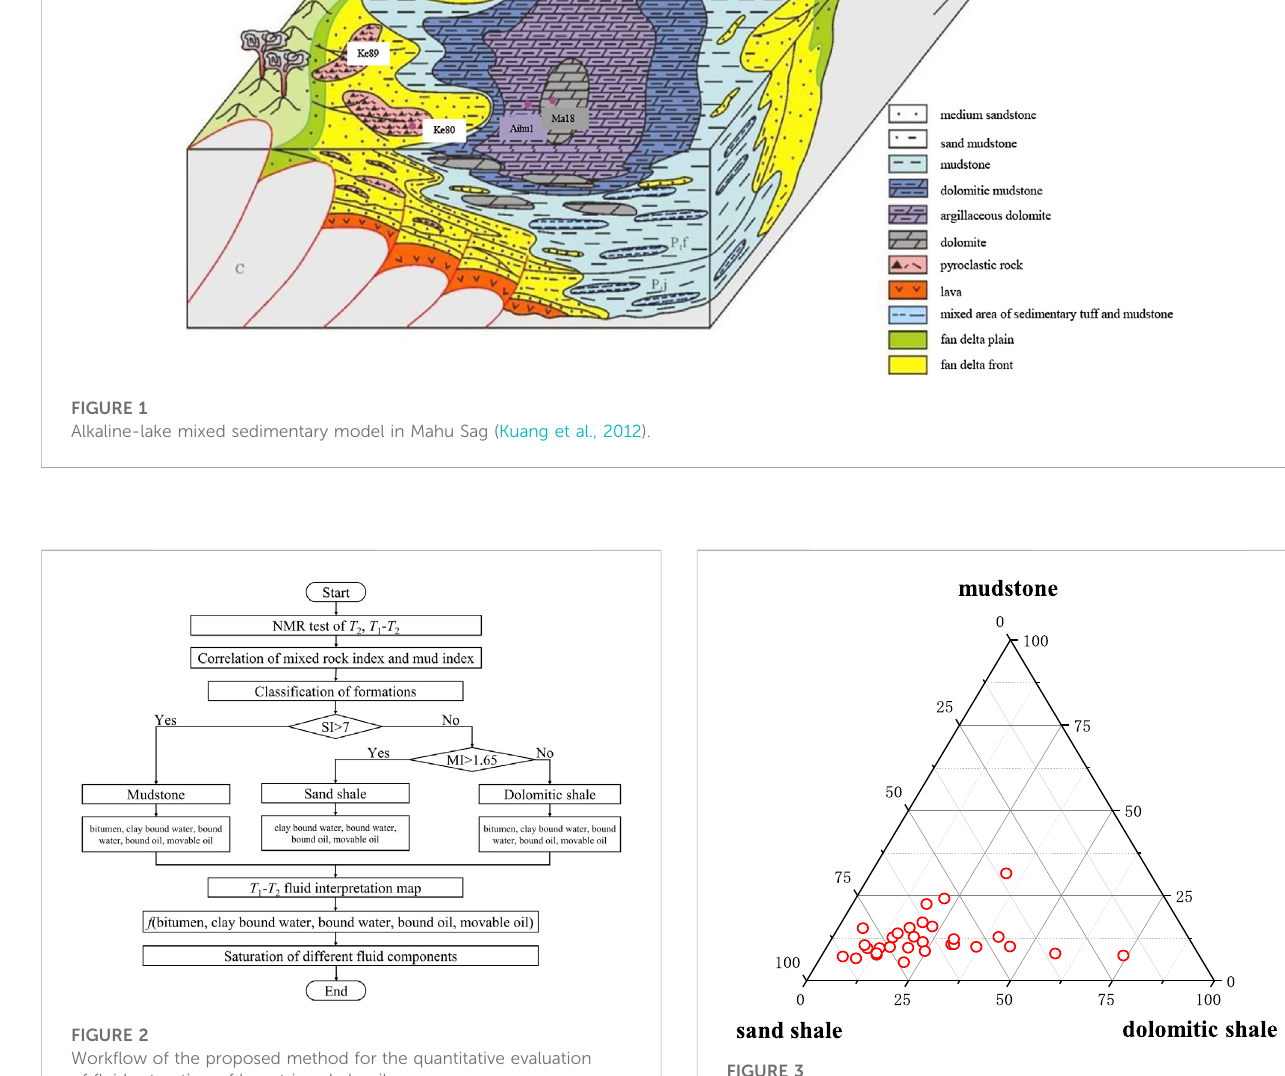
17.2%. The TOC content ranges from 0.01 wt% to 1.07 wt%, with an